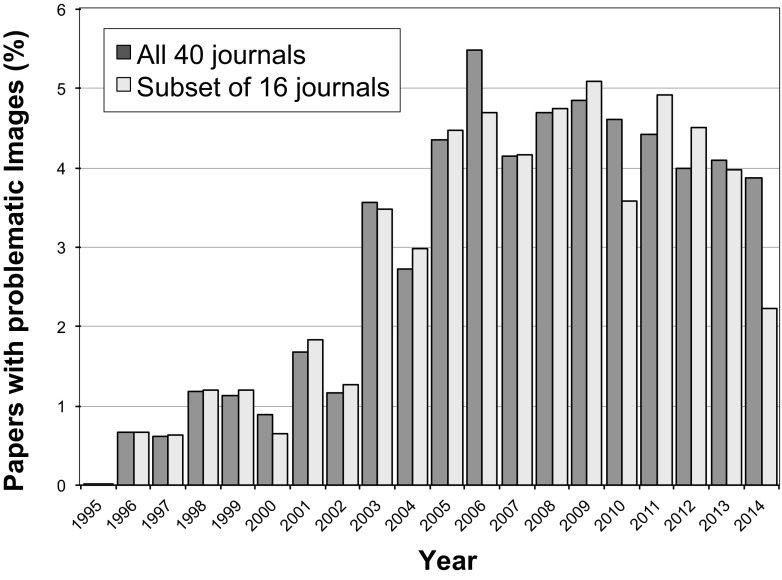
Percentage of papers containing inappropriate image duplications by year of publication. No papers with duplications were found in 1995. The dark gray bars show the data for all 40 journals. The light gray bars show a subset of 16 journals for which papers spanning the complete timespan of 20 years were scanned. The total numbers of papers screened in each year are shown in Fig. 1.